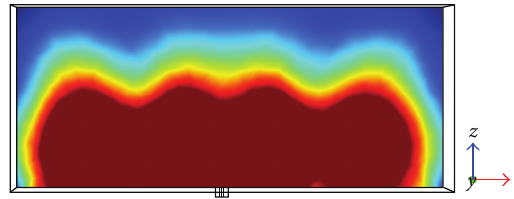
Figure 7: SAR distribution in the plane parallel to the symmetrical fed applicator aperture. The color bar here is the same as in Figure